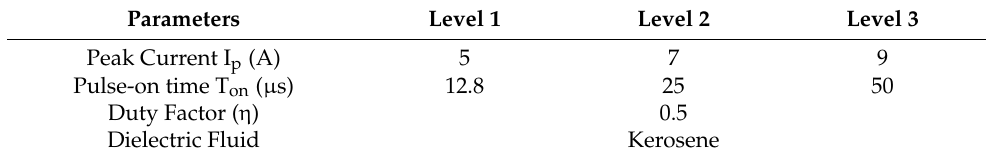
Table 2. Inputparameters.